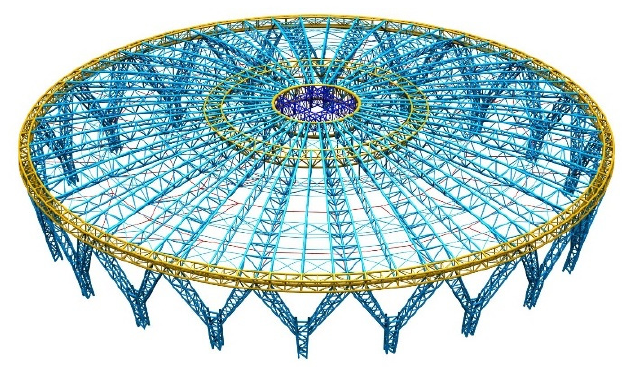
Figure 2. The three-dimensional steel structure drawing of the main gymnasium.